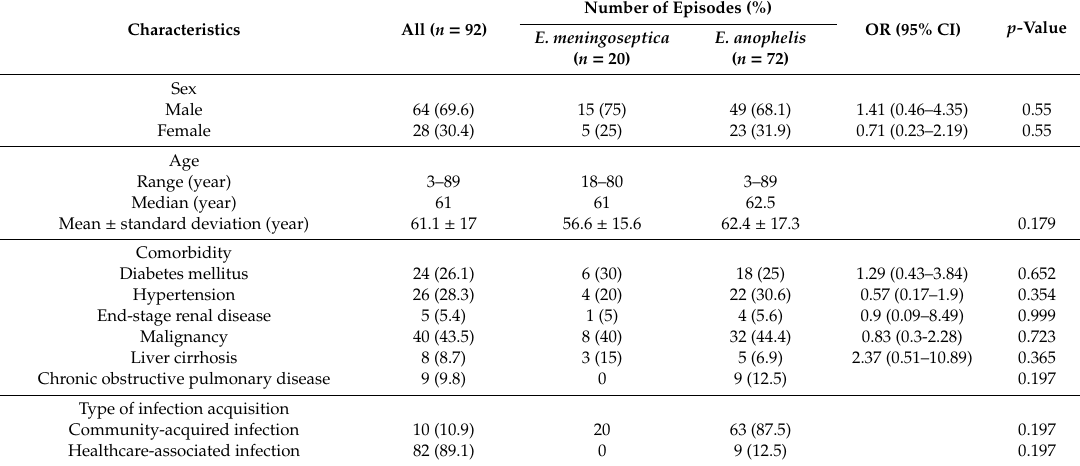
Demographic characteristics, clinical information, and outcome of patients with E. meningoseptica and E. anophelis